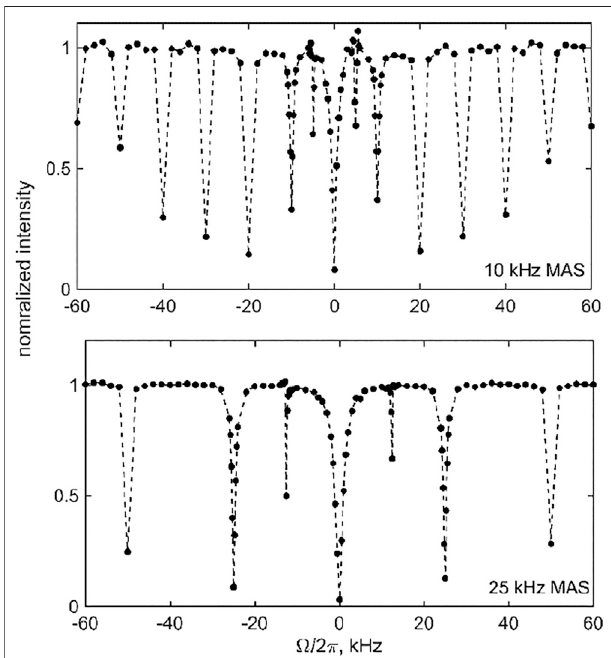
FIGURE 7 | Experimental 2 H MAS CEST pro fi les for DMS-D6 at 270 K and 17.6 T for the 1.3 kHz RF fi eld strength and T (cid:2) 3 ms. Normalized integrated central band intensity versus resonance offset Ω / 2 π for MAS rates of 10 kHz (upper panel) and 25 kHz (lower panel). The dotted lines are shown to guide the